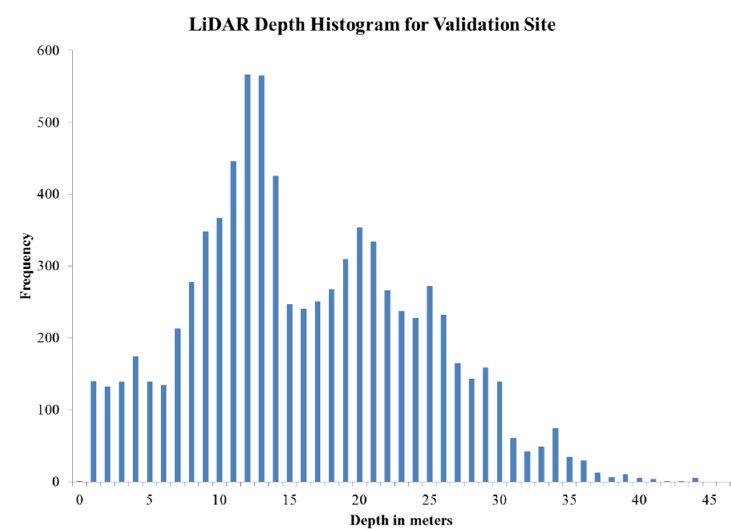
Figure 8. LiDAR SHOALS depth frecuency histogram for the selected points in the site validation area in Southwestern Puerto Rico.